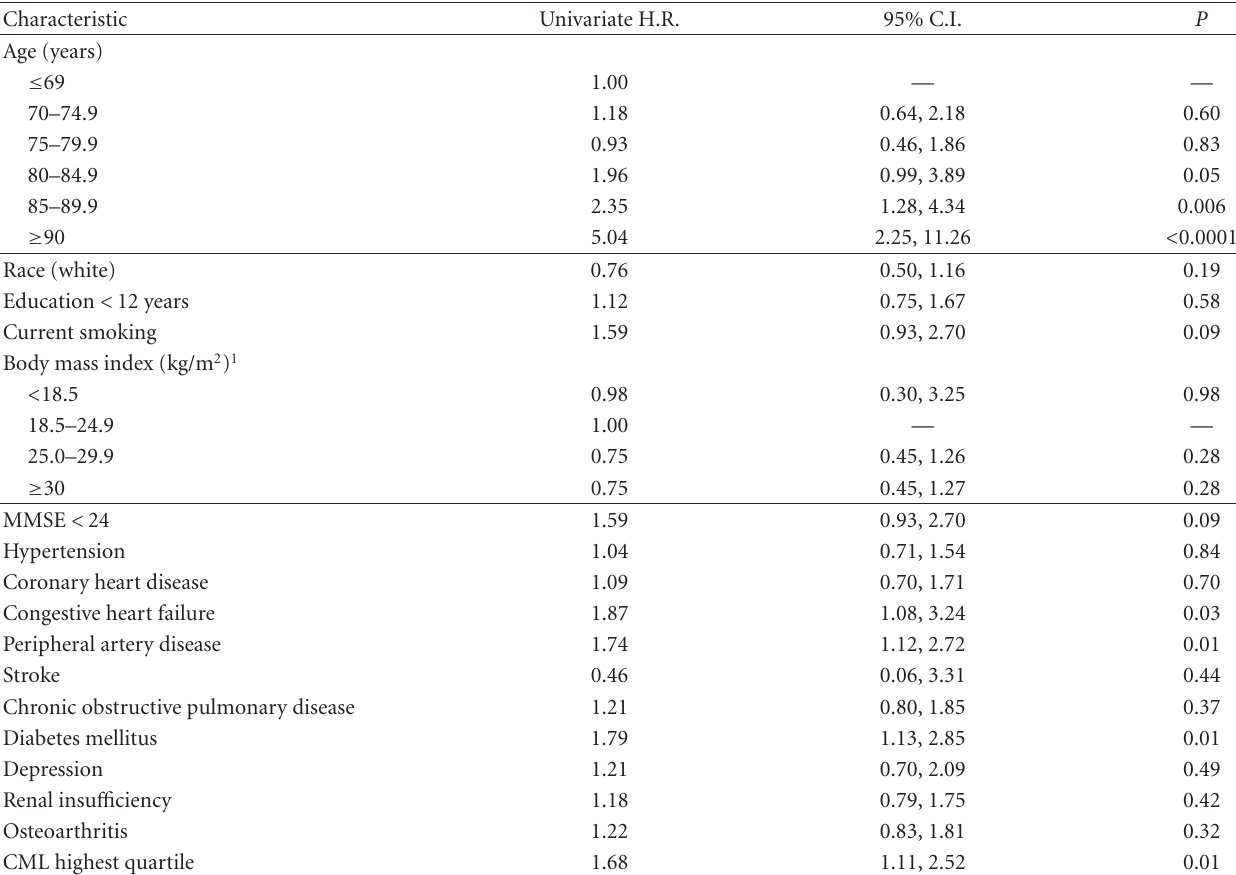
Table 2: Univariate Cox proportional hazard models for demographic and health characteristics and incidence of severe walking disability in the women’s health and aging study I ( N = 394).